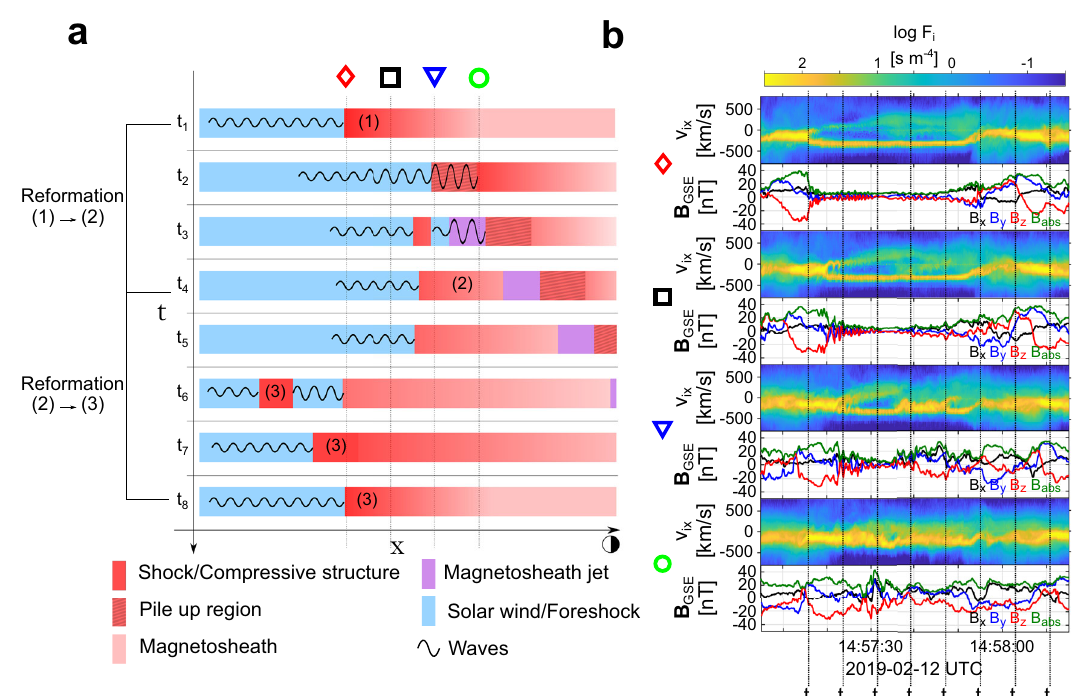
Fig. 8 Magnetosheath jet formation mechanism. a Sketch of the jet formation mechanism as a result of the bow shock reformation cycle. Magnetosheath jet appears as compressed solar wind that is effectively observed downstream of the shock through the generation of a secondary local shock front, upstream of the initial one. Note that due to the string-of-pearl formation (see Fig. 1) the satellites are aligned in the x Geocentric Solar Ecliptic (GSE) coordinate b reduced 1D velocity distribution functions (VDFs) and magnetic fi eld measurements per spacecraft going from the furthest away from the Earth to the closest. The interpretation of the satellite measurements (Figs. 2 – 6) are indicated by the vertical dotted lines. The numbering of the different magnetic structures corresponds to the same structures as shown in the above fi gures. All the information that does not appear in the measurements (vertical lines of panel a ) are inferred from the evolution of the observed structures and therefore are